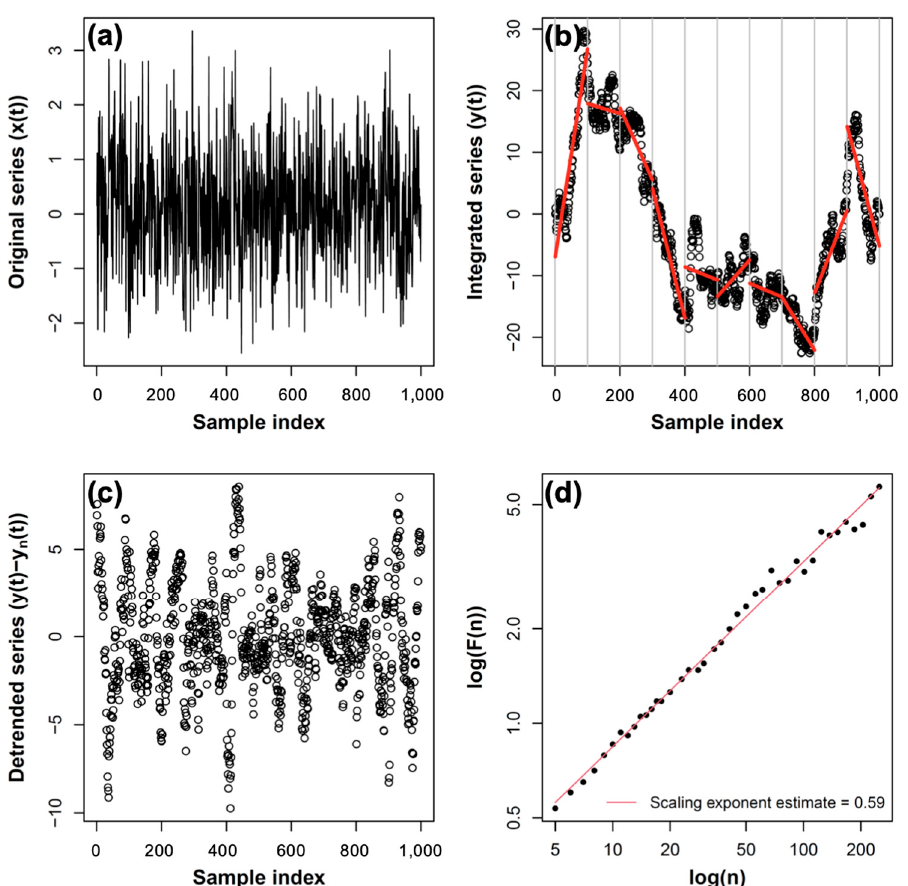
Figure 3. The steps of the detrended fluctuation analysis (DFA) method: ( a ) a long-range correlated series ( α = 0.6); ( b ) the integrated series and its best linear fits at n = 100 samples; ( c ) the detrended series at n = 100 samples; ( d ) the fluctuation function versus the box size.